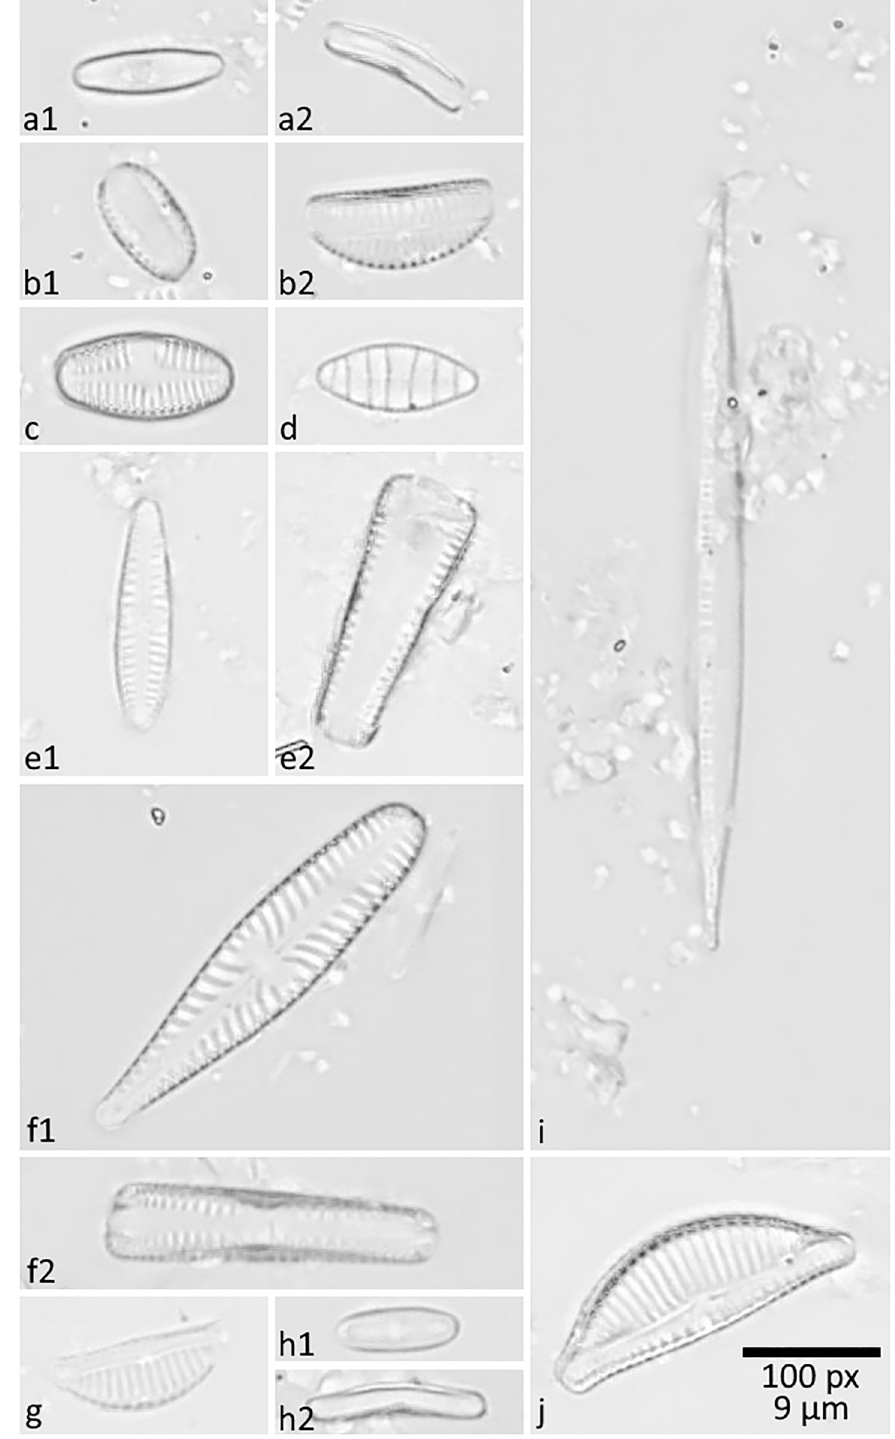
Fig 1. Typical examples of the ten most abundant diatom species to demonstrate their morphological diversity. a1, a2) Achnanthidium minutissimum in valvar and pleural view; b1, b2) Amphora pediculus in valvar and pleural view; c) Planothidium lanceolatum; d) Denticula tenuis; e1, e2) Gomphonema pumilum var. rigidum in valvar and pleural view; f1, f2) Gomphonella olivacea in valvar and pleural view; g) Encyonema minutum; h1, h2) Achnanthidium rivulare in valvar and pleural view; i) Nitzschia dissipata; j) Encyonema ventricosum.